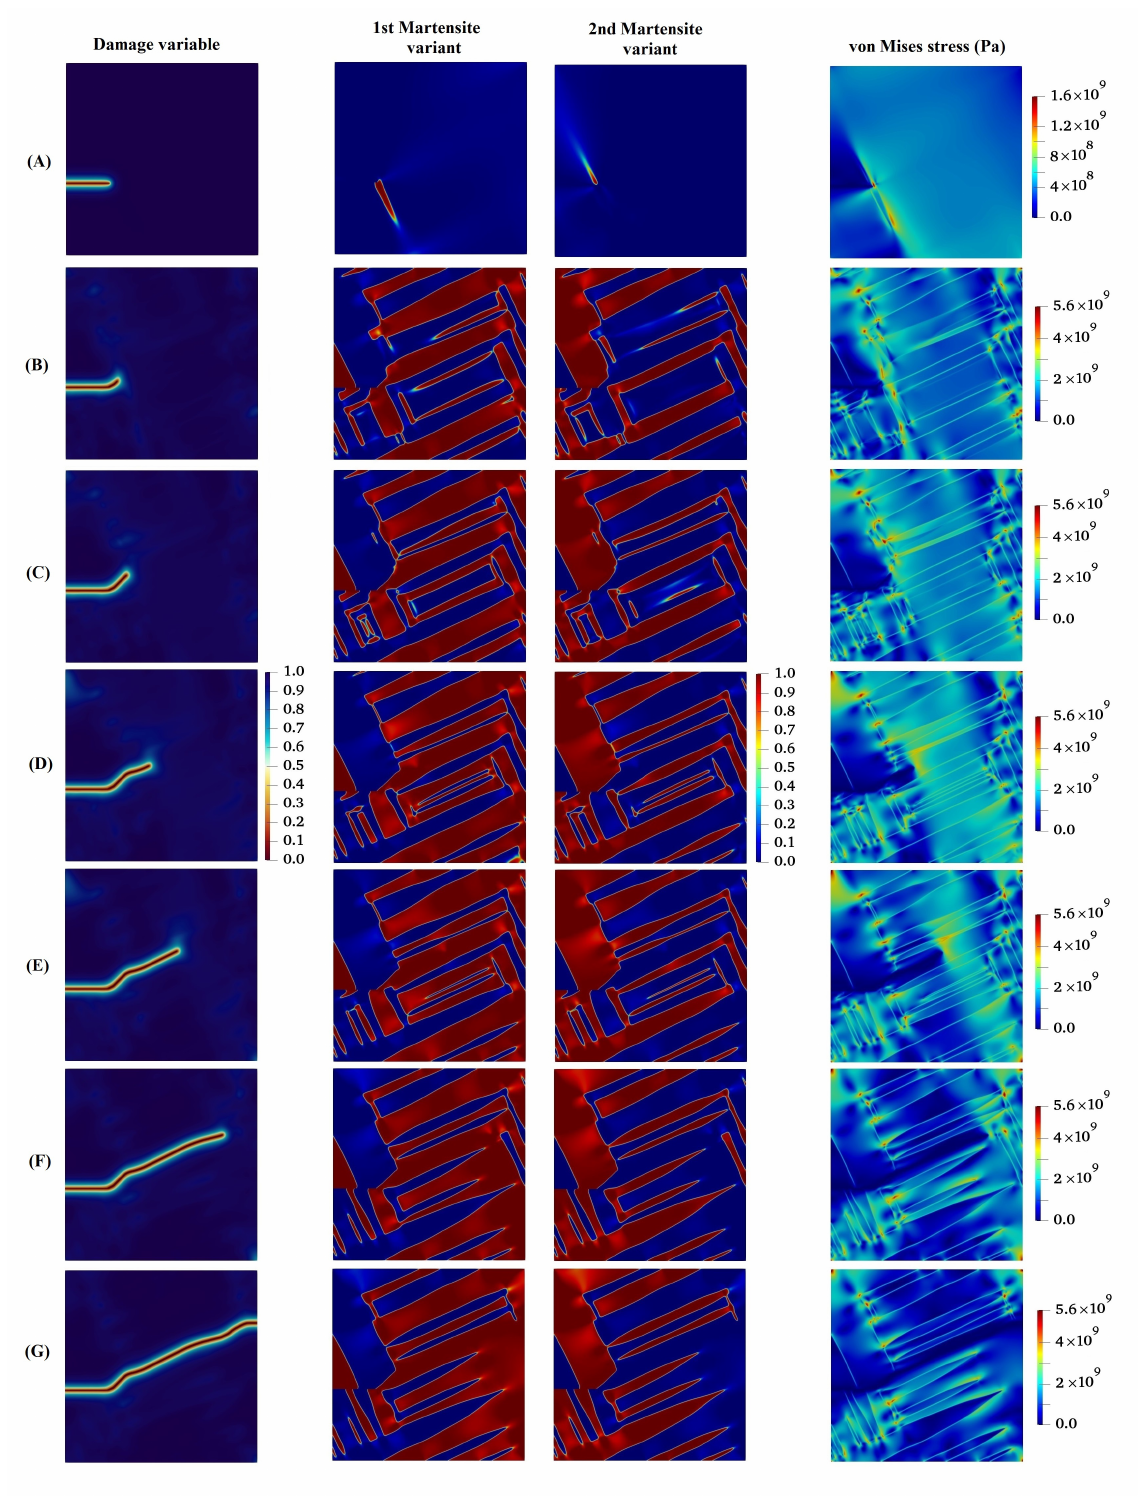
Figure 6. Evolution of damage variable, two martensite variants, and von Mises stress in the austenitic microstructure under Mode I loading with crystal lattice orientation of 15°